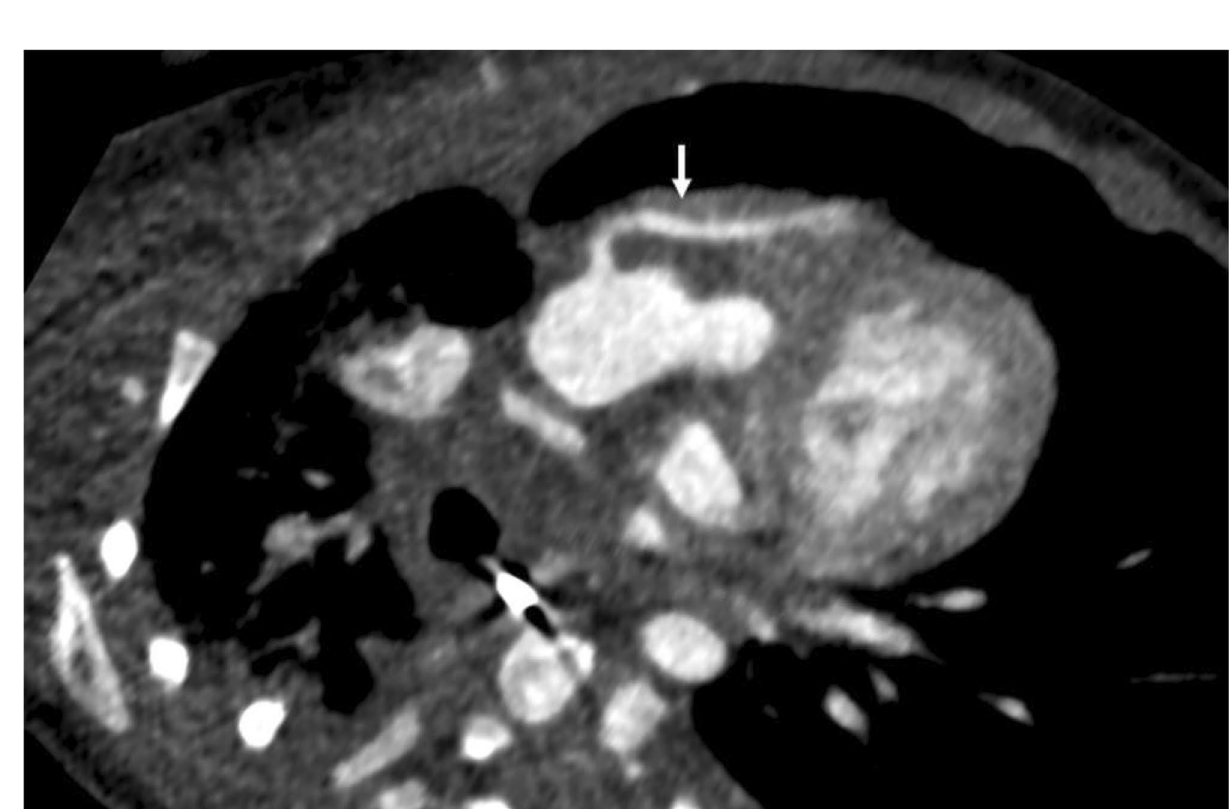
Figure 5. Detailed 3D angulated reconstruction visualizing the right main coronary artery (arrow) in a 2-month-old male newborn with Taussig-Bing